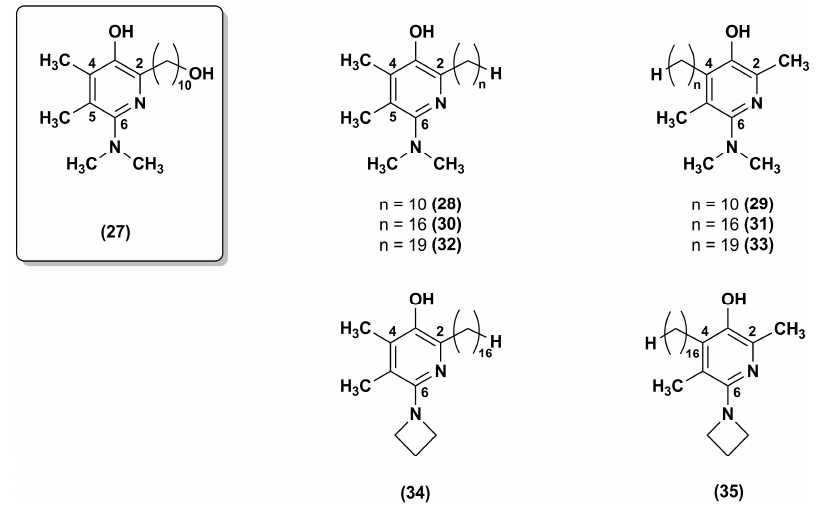
Figure 6. Chemical structures of compound 27 analogues.